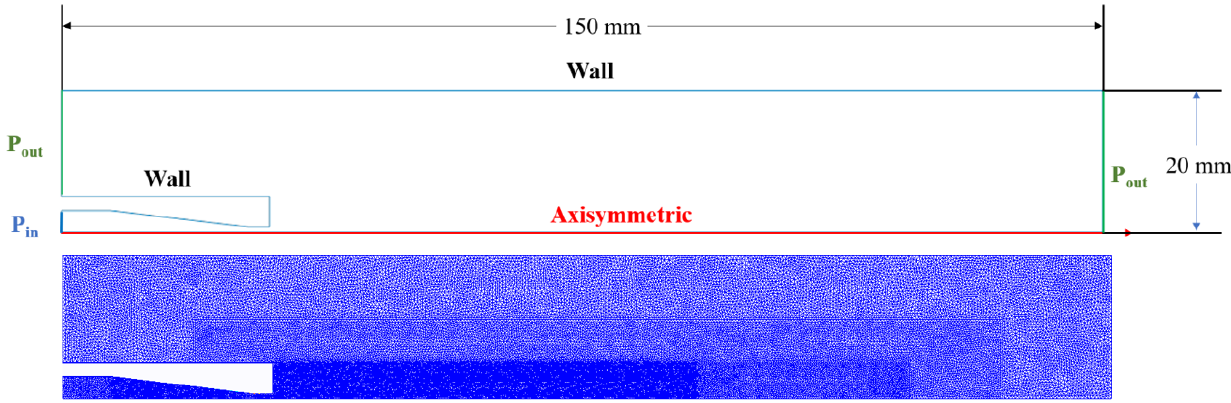
Figure 6. Geometry and mesh structure for conical nozzle. Domain size: 150 cm × 20 cm.